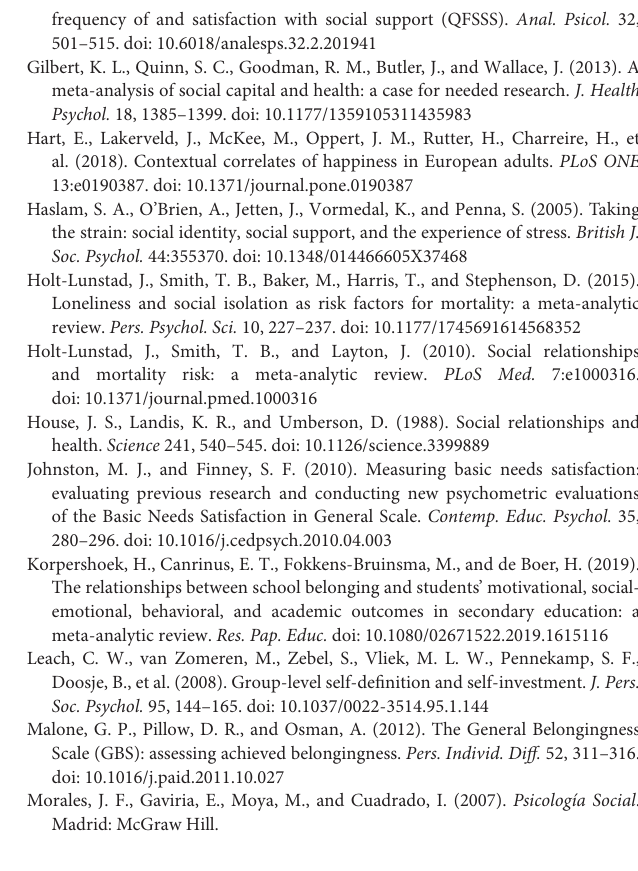
TABLE 3 | Effects of participation in collective gatherings and perceived emotional synchrony on well-being. Consequences Examples Relation with SB and/or WB High positive affect and Páez et al. (2015), Bouchat et al. (2020). Increase Affect Balance in SWB and self-acceptance in PWB self-esteem. Pizarro et al. (2018). Increases affect balance in SWB, mastery and purpose in life in Positive and self-transcendent emotions (e.g., joy, awe). Fusion of identity. Páez et al. (2015). Increases Positive relationships with others and purpose in life in Social integration. Pelletier (2018). Increases Positive affect in SWB, Positive relationships with others Positive shared beliefs and Páez et al. (2015), Garcia and Rimé social values.